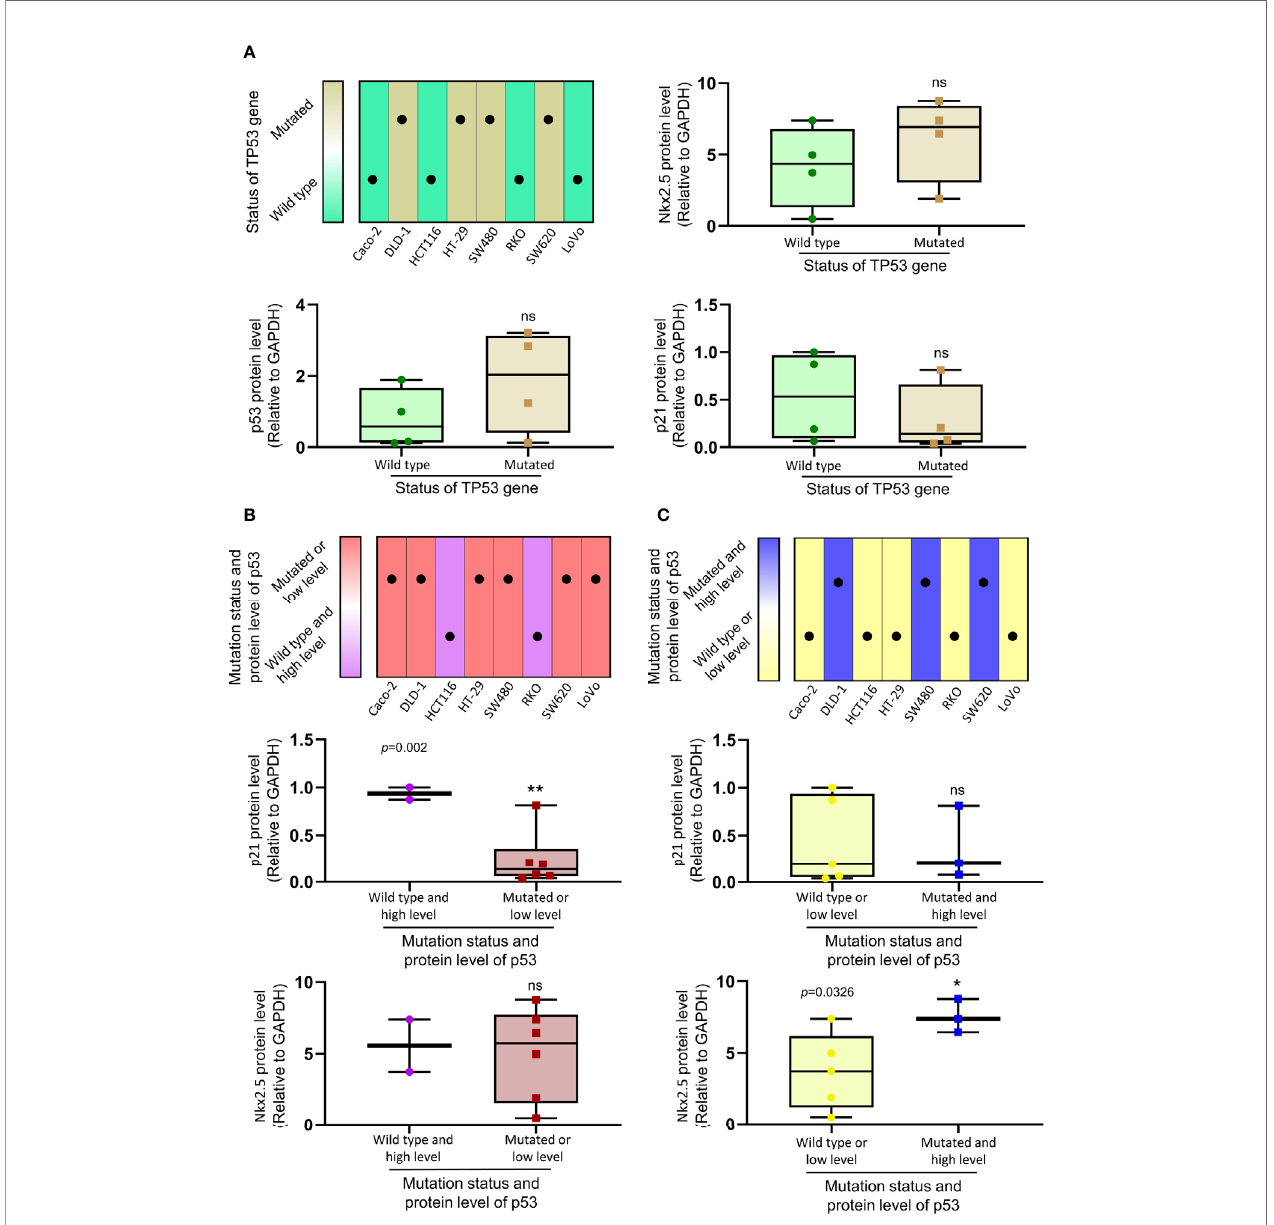
FIGURE 7 | The relationship between the expression of Nkx2.5, p21 WAF1/CIP1 , p53 and mutational status of TP53. (A) Protein levels of Nkx2.5, p53, and p21 WAF1/CIP1 were compared between CRC cell lines with wild-type TP53 and those with mutated TP53. (B) Protein levels of p21 WAF1/CIP1 and Nkx2.5 were compared between CRC cell lines with high expression of wild-type p53 and those with mutated or low expression of wild-type p53. (C) Protein levels of p21 WAF1/CIP1 and Nkx2.5 were compared between CRC cell lines with high expression of mutated p53 and those with wild-type or low expression of mutated p53. * represents P < 0.05; ** represents P < 0.01; ns represents P ≥ 0.05 (no statistical signi fi